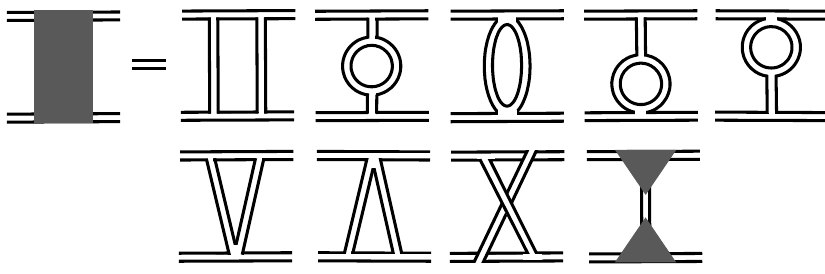
Figure 16 . The kernel of the integral equation with possible topological rung insertions. The rungs are shown schematically and the distinction between number conserving and number changing processes (or soft and hard momenta) is not denoted explicitly here since both these classes come from the same topological structures.